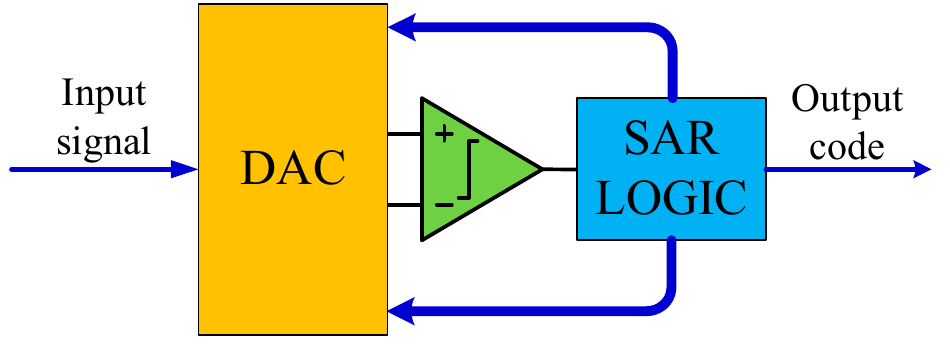
Figure 2. Building blocks of SAR ADC.